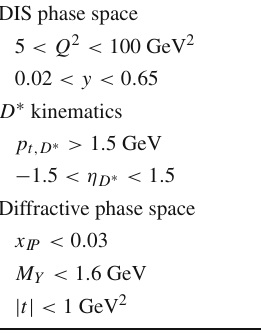
Table 1 Definition of the phase space of the cross